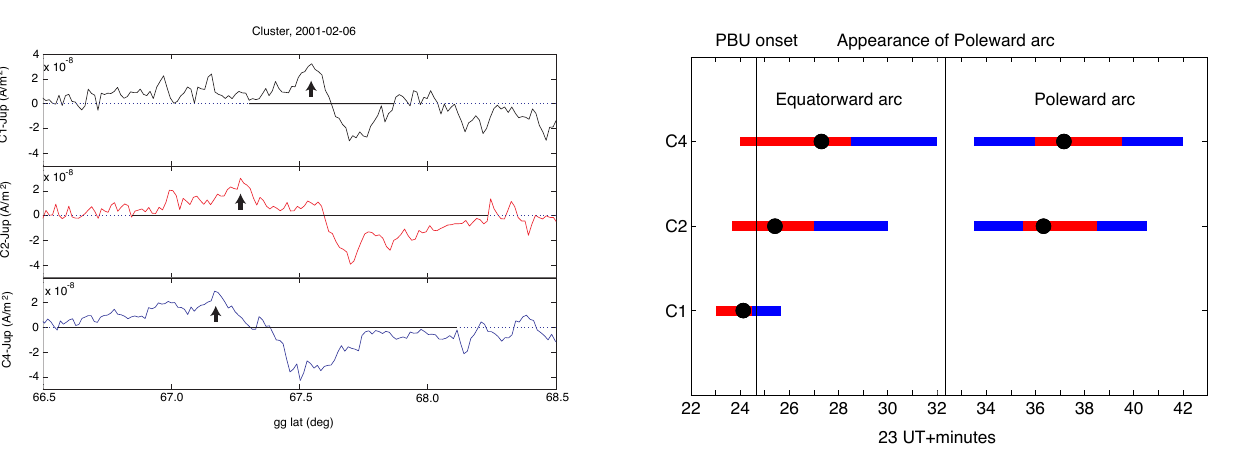
Fig. 4. Timeline of the C1, C2 and C4 crossings of the two arcs. Red (blue) horisontal bars denote upward (downward) FAC regions. Black dots denote times of maximum upward FACs. In addition, vertical lines show pseudo-breakup (PBU) onset time and the time when the poleward arc starts to